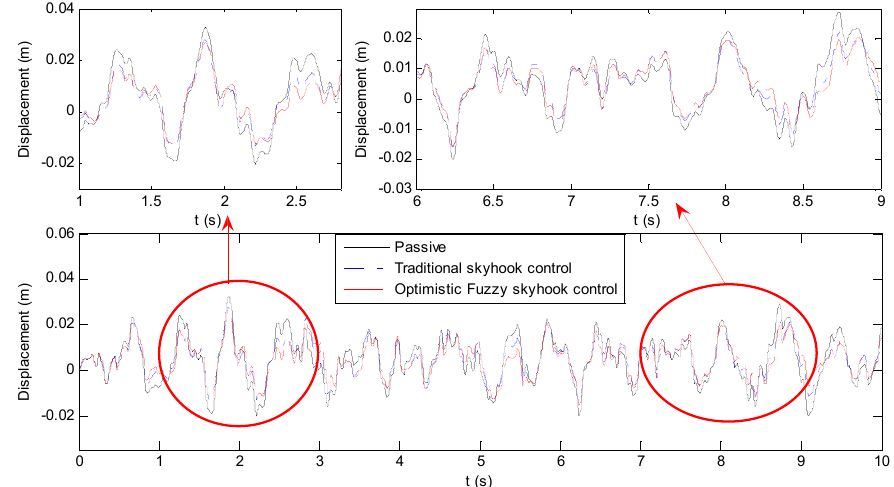
Energies 2021 , 14 , x FOR PEER REVIEW Figure 17. Comparison of the suspension dynamic deflections using the three control methods under C class road excitation. Figure 17. Comparison of the suspension dynamic deflections using the three control methods Figure 17. Comparison of the suspension dynamic deflections using the three control methods under C class road excitation. under C class road excitation.